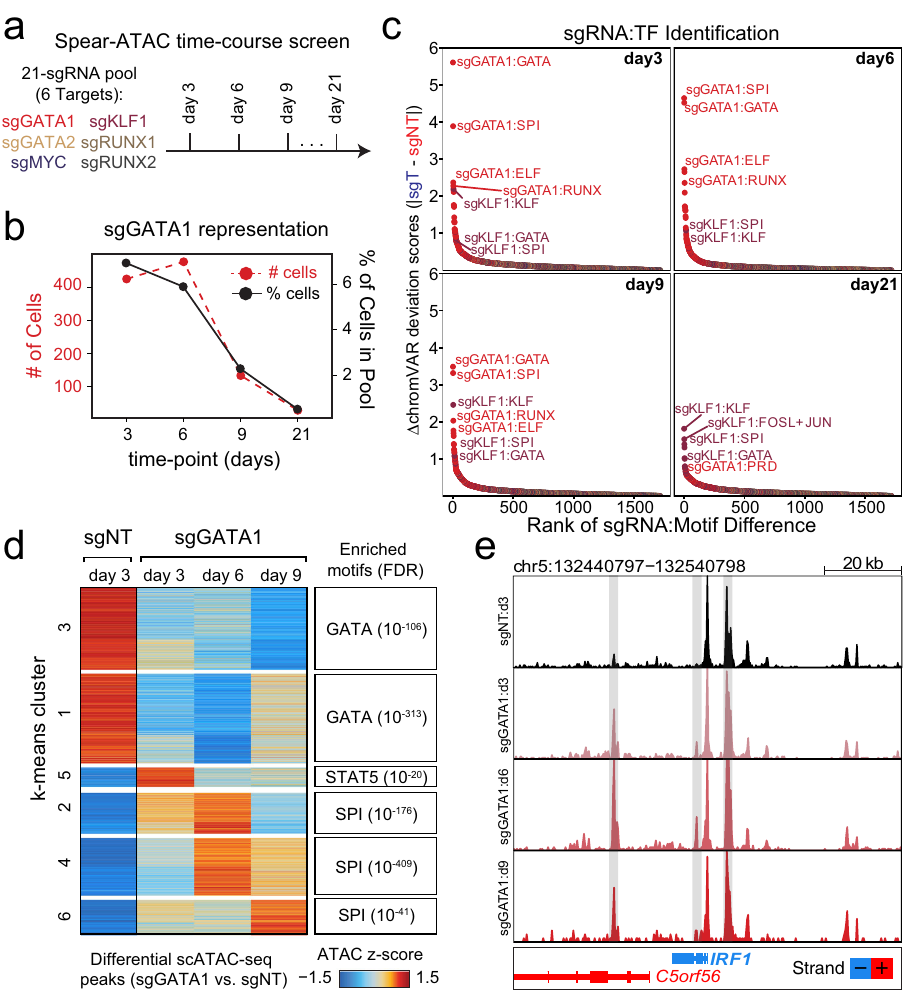
Fig. 2 Assessing trans regulatory perturbations over time using Spear-ATAC. a Schematic of Spear-ATAC time-course experiment with a 21-sgRNA pool analyzed at 4 time-points (3, 6, 9, and 21 days post-transduction). b Change in sgGATA1 representation over time, represented by the number of cells analyzed per time-point (red) and the % of cells in the total pool (black). c Rank ordered plot of sgRNA:TF perturbations to identify top hits in the K562 time-course screen at the indicated time points. d (Left) Heatmap of chromatin peak accessibility for each scATAC-seq sub-population using the top differential scATAC-seq peaks. Each row represents a z score of log 2 normalized accessibility within each group using scATAC-seq. Day 21 was excluded due to low representation of sgGATA1 cells at this time point. (Right) Transcription factor hypergeometric motif enrichment with FDR indicated in parentheses. e Pseudo-bulk ATAC-seq track at the IRF1 locus for sgGATA1 (day 3, day 6, day 9, and day 21) and sgNT cells (day3). Light grey box indicates peak regions that increased in accessibility in the sgGATA1 vs sgNT cells. Day 21 was excluded due to low representation of sgGATA1 cells at this time